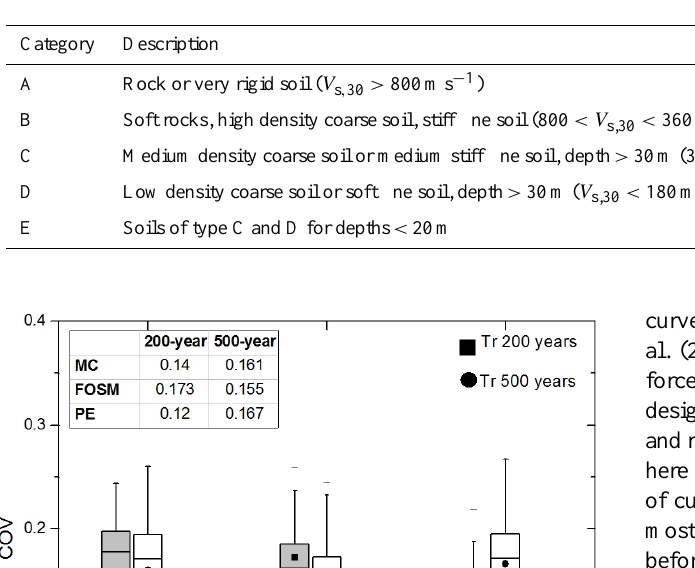
Fig. 6. COV values for the 500-yr flood scenario, calculated by means of Monte-Carlo-Simulation, FOSM, and Point Estimate Approach. Table 4. Soil categories and amplification factors S s (D.M 14/01/08). F 0 is the maximum spectral amplification at a reference horizontal rigid site.